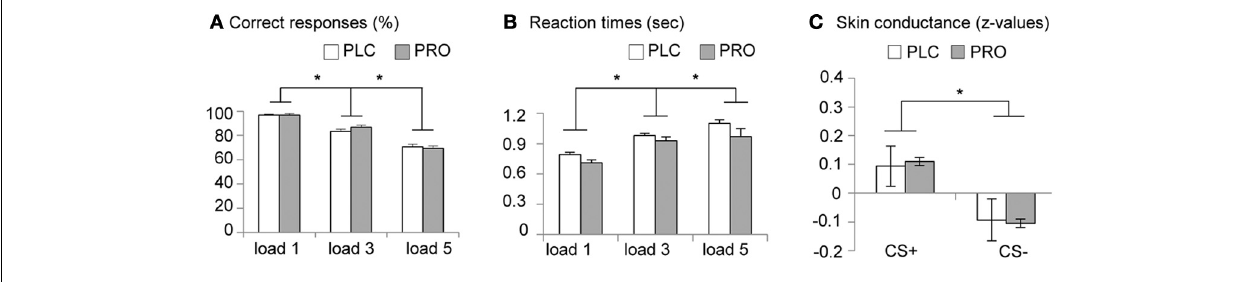
FIGURE 2 | Behavioral data. Placebo- and propranolol-treated subjects did not differ in (A) working memory accuracy and (B) response latencies ( ∗ p < 0 . 05, two-tailed). (C) Larger SCRs during CS + vs. CS − throughout the conditioning procedure suggests successful conditioning. Z scores were